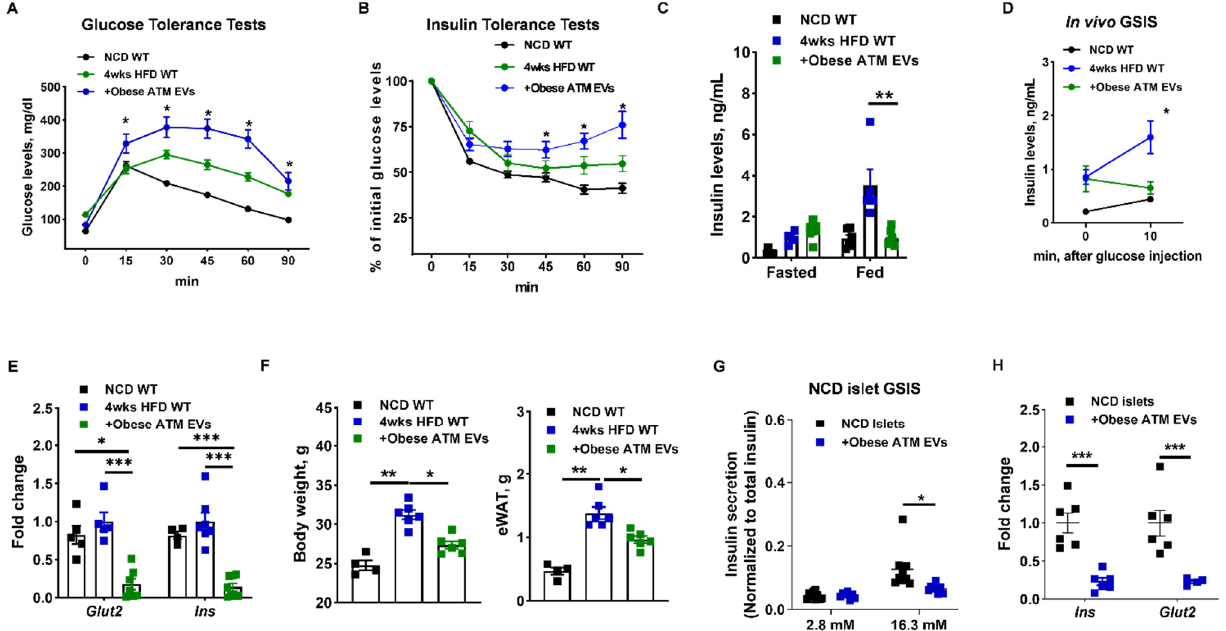
Figure 2. Obese ATM EVs blunt the insulin secretion of obese mice. ( A and B ) Glucose and insulin tolerance tests were performed in high fat diet (HFD)-fed WT recipient mice after 4 weeks obese ATM EV treatment. ( C ) Insulin levels after 16 h fasting or feeding. ( D ) The insulin levels of HFD recipient mice after 10 min glucose injection. ( E ) The abundance of genes associated with insulin secretion in the islets of HFD recipients. ( F ) The epididymal fat mass and body weight of HFD mice after 4 weeks obese ATM EV treatment. ( G ) The effect of obese ATM EVs on the glucose-stimulated insulin secretion (GSIS) of islets isolated from normal chow diet (NCD) fed mice. ( H ) The expression of Ins and Glut2 in NCD islets treated with obese ATM EVs. Data are presented as the mean ± SEM. A–B, D, N = 5–8 per group. * p < 0.05, ** p < 0.01, *** p < 0.001, Student’s t test ( C and D , G and H ), one-way ( E and F ) or two-way ( A and B ) ANOVA.